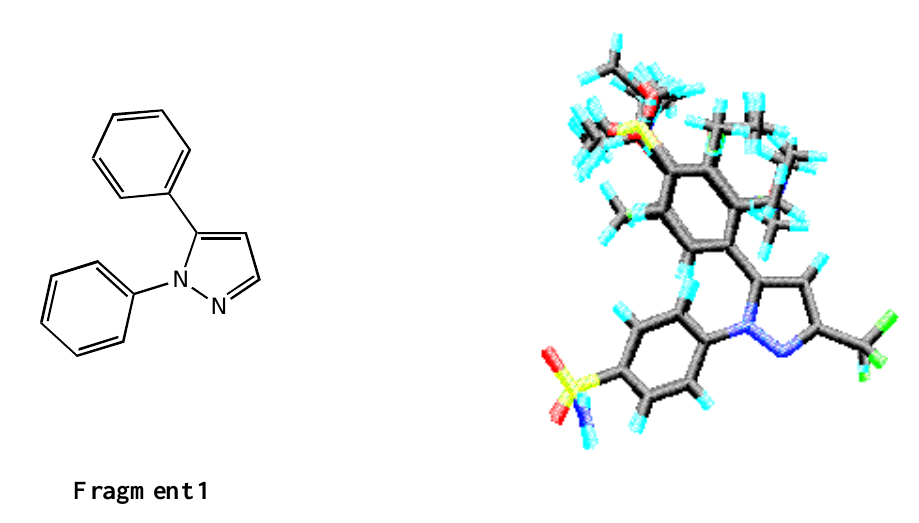
Figure 1. Fragment 1 and alignment of all molecules using the Sybyl database alignment procedure.